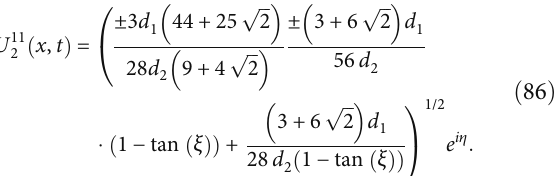
ð x , t Þj for NLFD of order α and for parameters δ 2 ffiffiffiffiffiffiffiffiffiffiffiffiffiffiffiffiffiffiffiffiffiffiffiffiffiffiffiffiffi p δ − 2 δ − 8 δ / δ 2 1 3 2 ffiffiffiffiffiffiffiffiffiffiffiffiffiffiffiffiffiffiffiffiffiffiffiffi